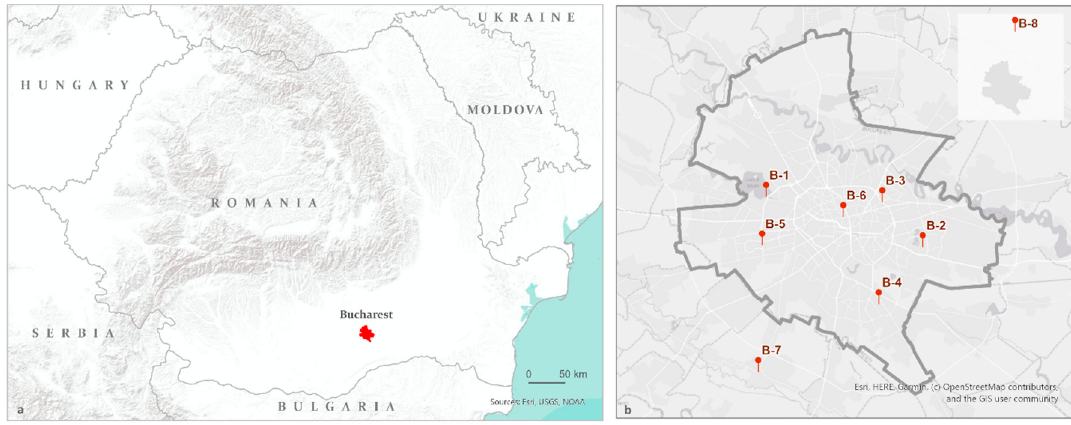
Figure 4. Location map of Bucharest ( a ) and the distribution of the air quality ground-based stations ( b ).